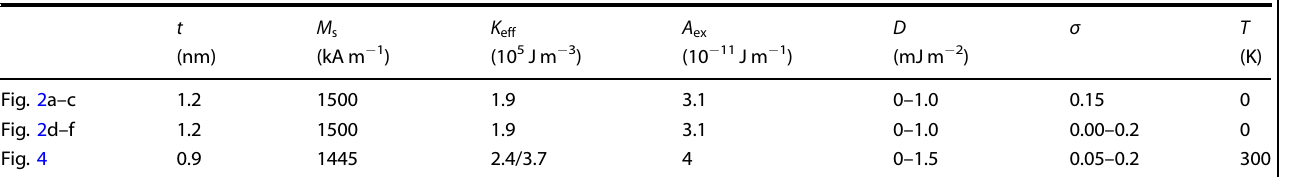
Model validation is performed with 10,000 testing images with different values of D created using the same code. D set